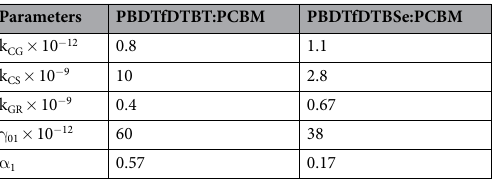
Table 2. Modeling results of PBDTfDTBT:PCBM and PBDTfDTBSe:PCBM blends. Since the extinction coefficients of the species are not known, standard units for the second order rate constants could not be obtained. Instead [absorbance units/second] was used.